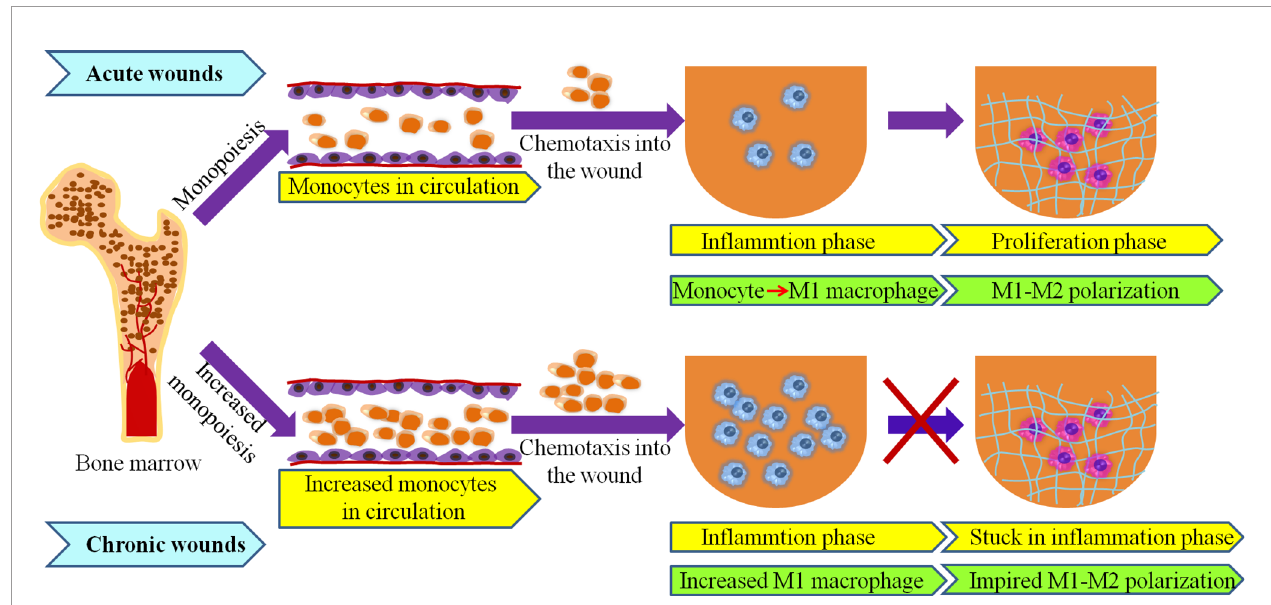
FIGURE 2 | Macrophages originate from bone marrow in acute and chronic wounds. High numbers of bone marrow-produced monocytes under elderly, obese and diabetes may lead to increased number of macrophage in chronic wound. Transition from M1- to M2- phenotypes is impaired in chronic